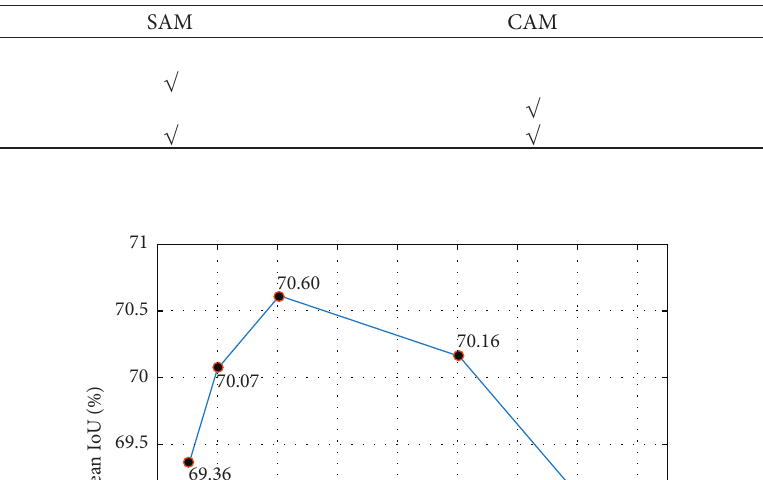
Table 1: Detailed performance of proposed network with and without SAM and CAM.